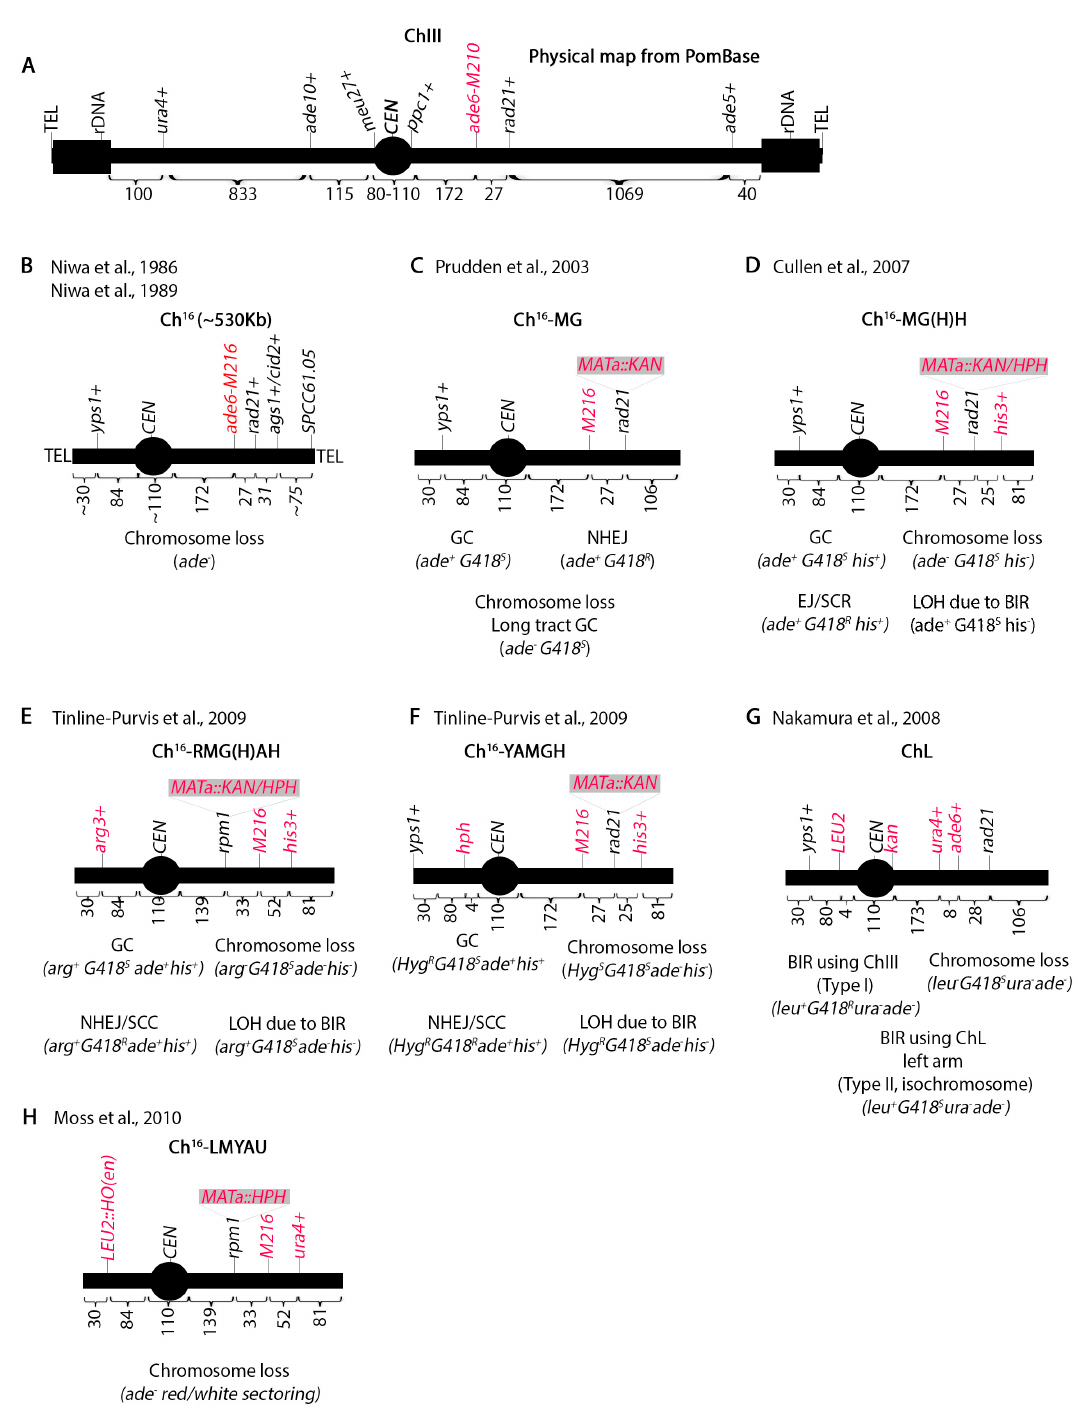
Figure 2. S. pombe mini-chromosome derivatives of Ch.III to study recombination. ( A ) Diagram of Chromosome III indicating the physical position of some genes. The numbers indicate kilobases. ade6-M210 provides intra-allelic complementation with ade6-M216 . Ch.III is approximately 3.5 Mb. (B ) The Ch 16 mini-chromosome isolated by Niwa et al. Ch 16 is 0.5 Mb and lacks rDNA repeats. Chromosome loss can be monitored by appearance of adenine auxotrophs. ( C ) Ch 16 -MG designed by Prudden et al. with the HO endonuclease restriction site at the rad21 locus. This chromosome can monitor, gene conversion, NHEJ and chromosome loss. ( D ) Modified Ch 16 -MG to include the his3 + marker close to the right telomere which can monitor LOH due to BIR. ( E ) The arg3 + marker was